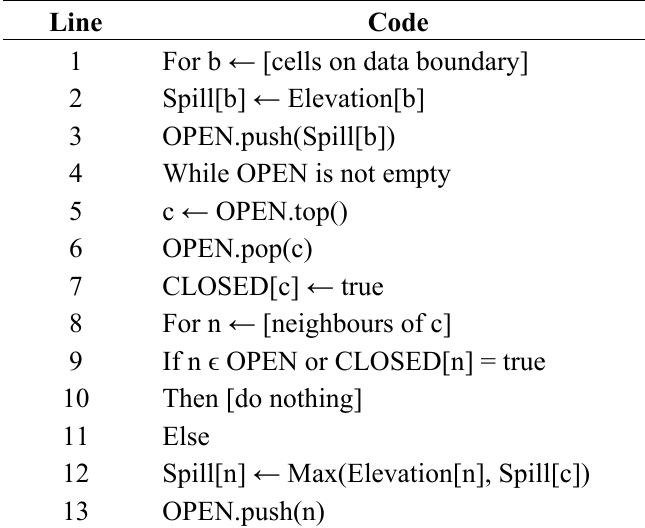
Table 1. Pseudo-code for Wang and Liu algorithm